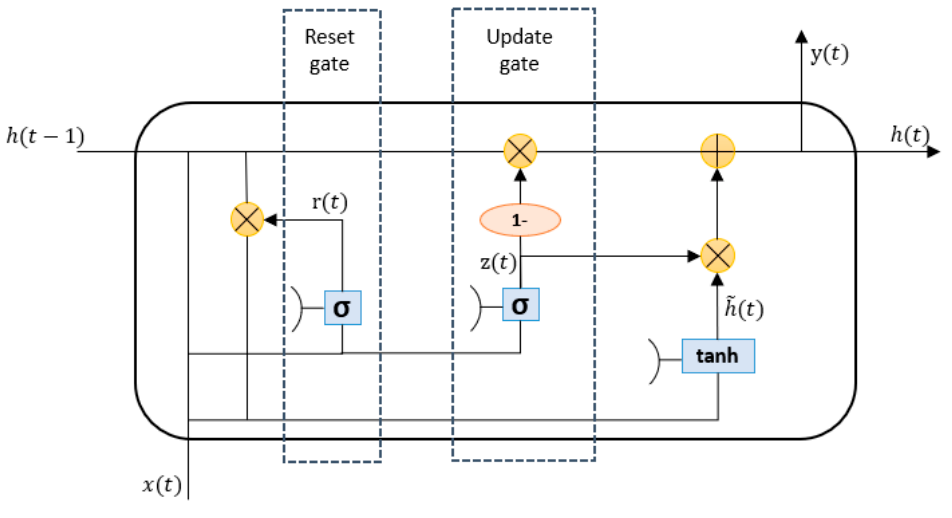
Figure 4. GRU network.